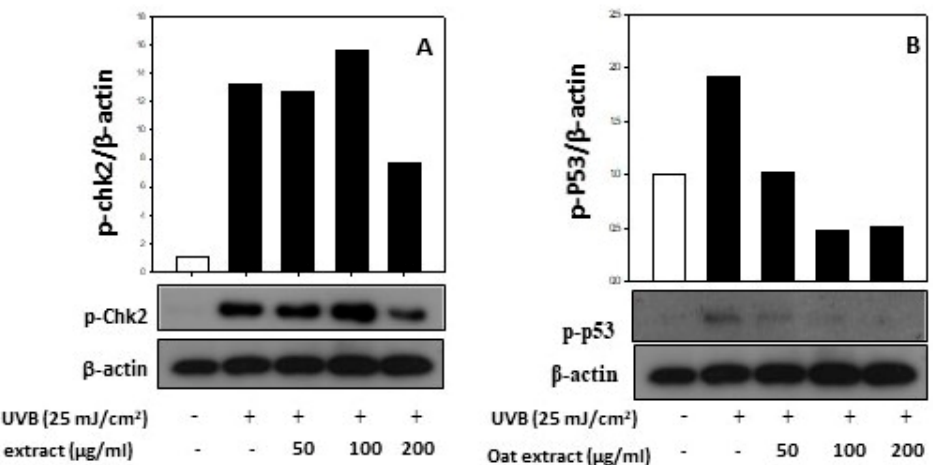
Figure 5. Effect of oat ( Avena sativa cv. Daeyang) 80% ethanol extract on the expression of phospho- chk2 ( A ) and phospho-p53 ( B ) in human keratinocytes HaCaT. Cells were treated with various concentrations (50–200 µ g/mL) of oat 80% ethanol extracts for 24 h, followed by incubation for 5 h after exposure of 25 mJ/cm 2 of UVB. Chk-2 and p-53 protein levels were assessed using immunoblotting. β -Actin was used as an internal control.